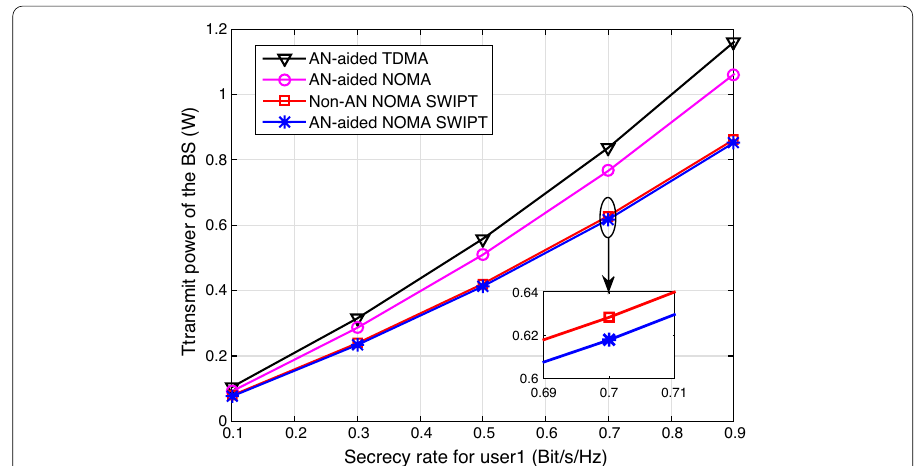
Fig. 5 The minimum transmission power of the BS versus the secrecy rate of user1